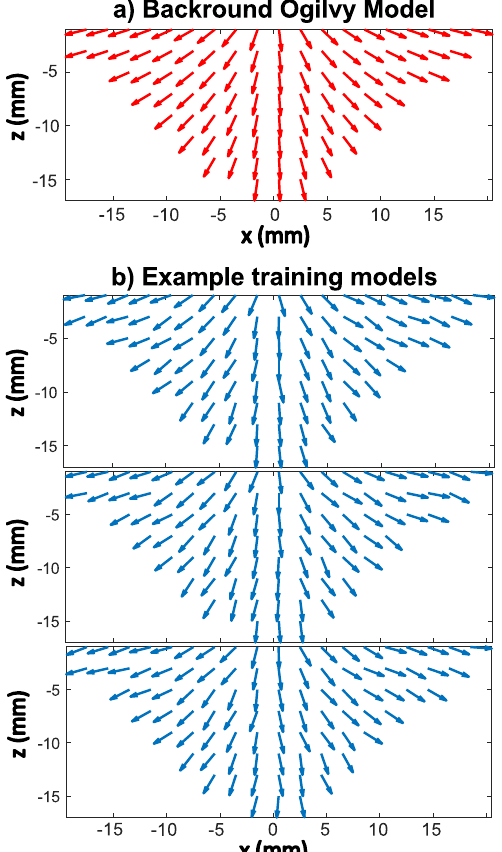
Figure 2. ( a ) Grain orientations given by the Ogilvy model (Equation (1)) used as an underlying background model for the training data. ( b ) Example grain orientation maps used to generate training data, computed as uniformly random perturbations to the Ogilvy model within ± 10 ◦